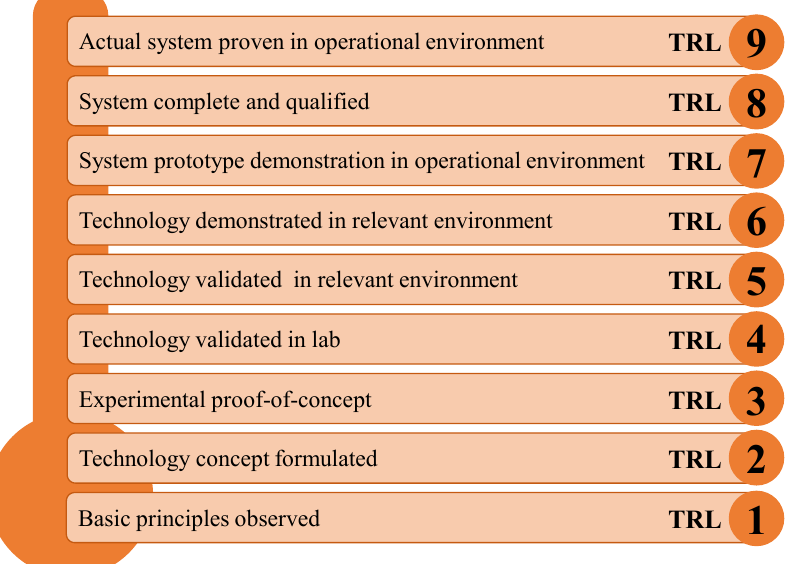
Figure 2. Technology Readiness Level (TRL)